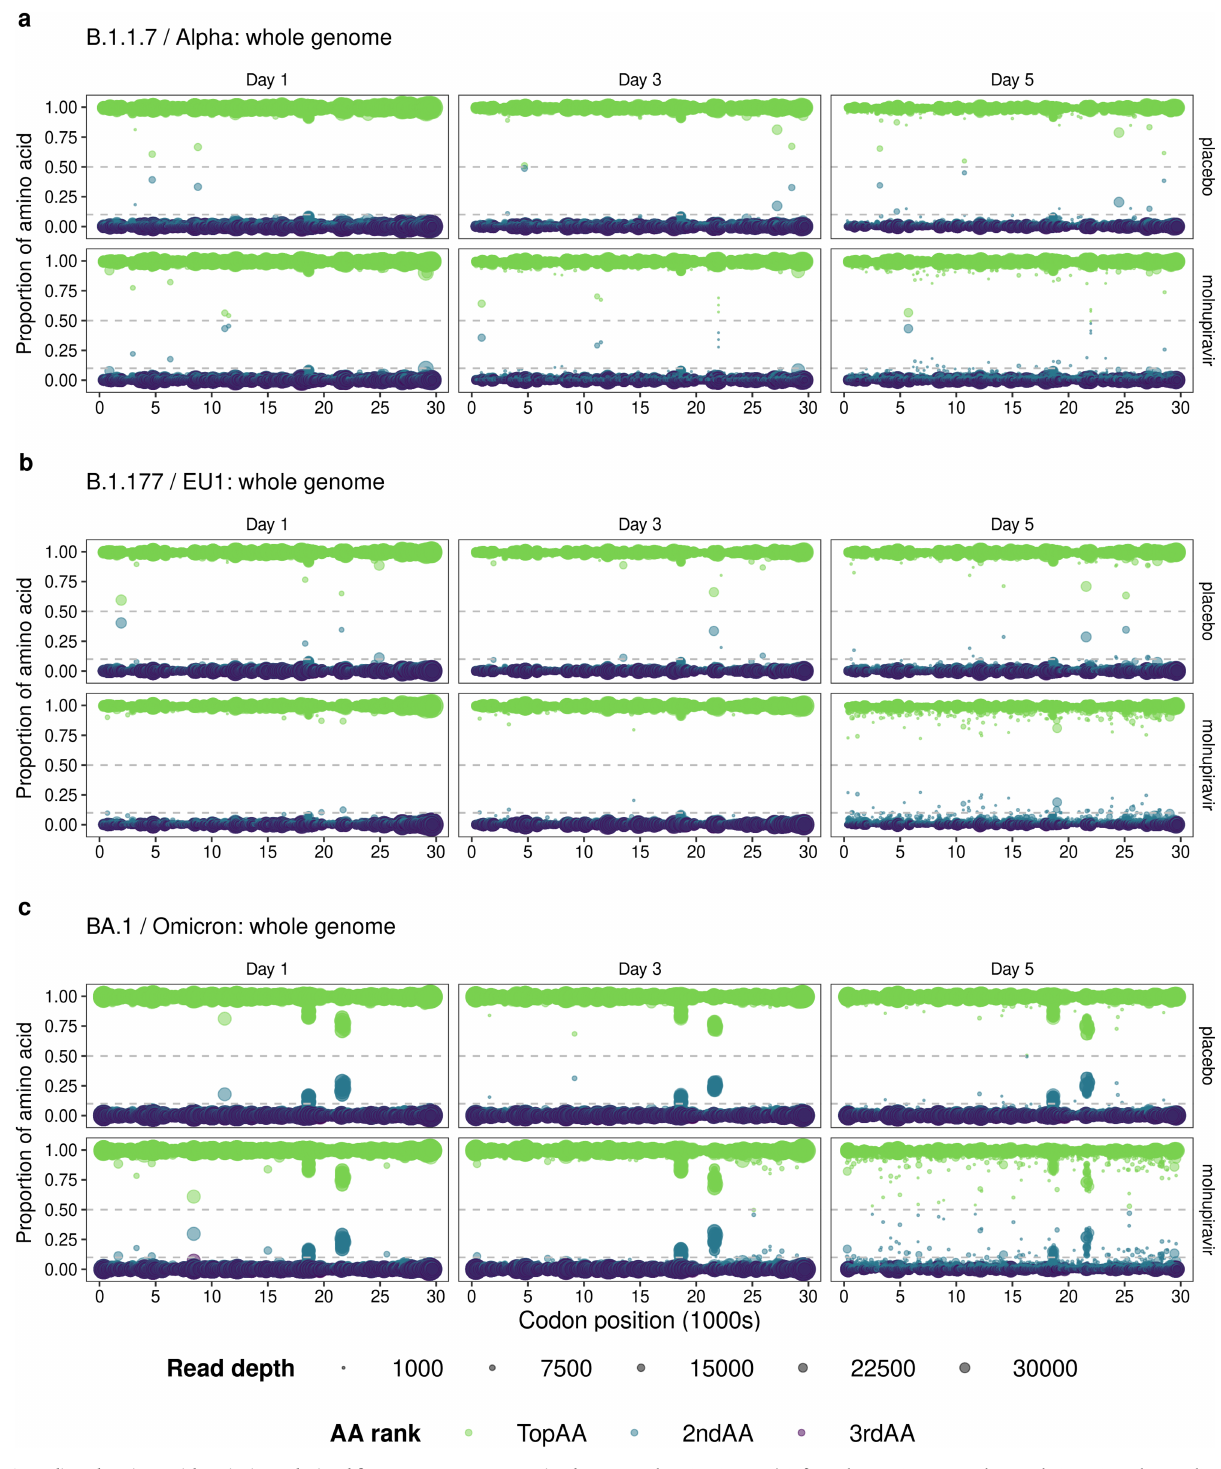
Fig. 3 | Predicted amino acid variations derived from SARS-CoV-2 RNA in the whole genome of B.1.1.7/Alpha, B.1.177/EU1 and BA.1/Omicron lineages. Pre- dicted amino acid variation derived from RNA sequence information across the whole genome in all a , alpha (placebo n =14, molnupiravir n =11); b B.1.177/EU1 (placebo n =10, molnupiravir n =8); and c BA.1/Omicron (placebo n =9,